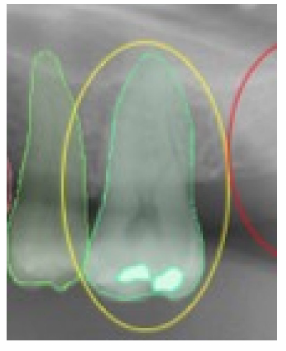
Figure 5. This selected view of Figure 1 shows the missing detection of the tooth filling in position 2.6. The assigned value was